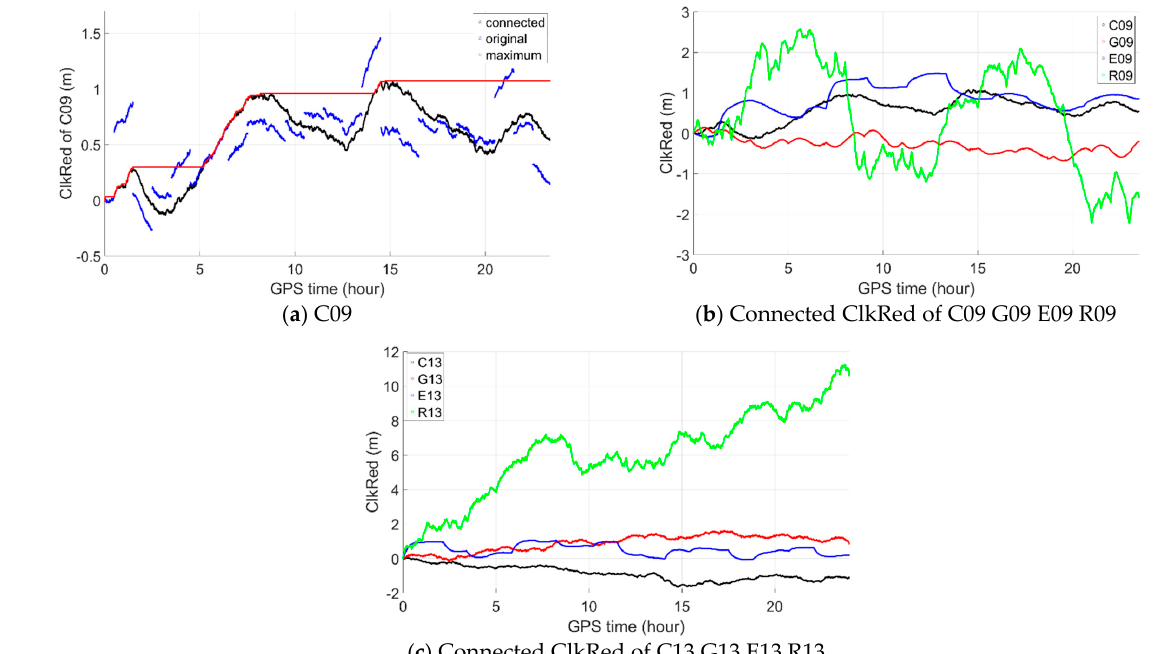
Figure 13. Original, connected and maximum clkRed ( a : C09, b : connected ClkRed of C09 G09 E09 R09, c : connected ClkRed of C13 G13 E13 R13).